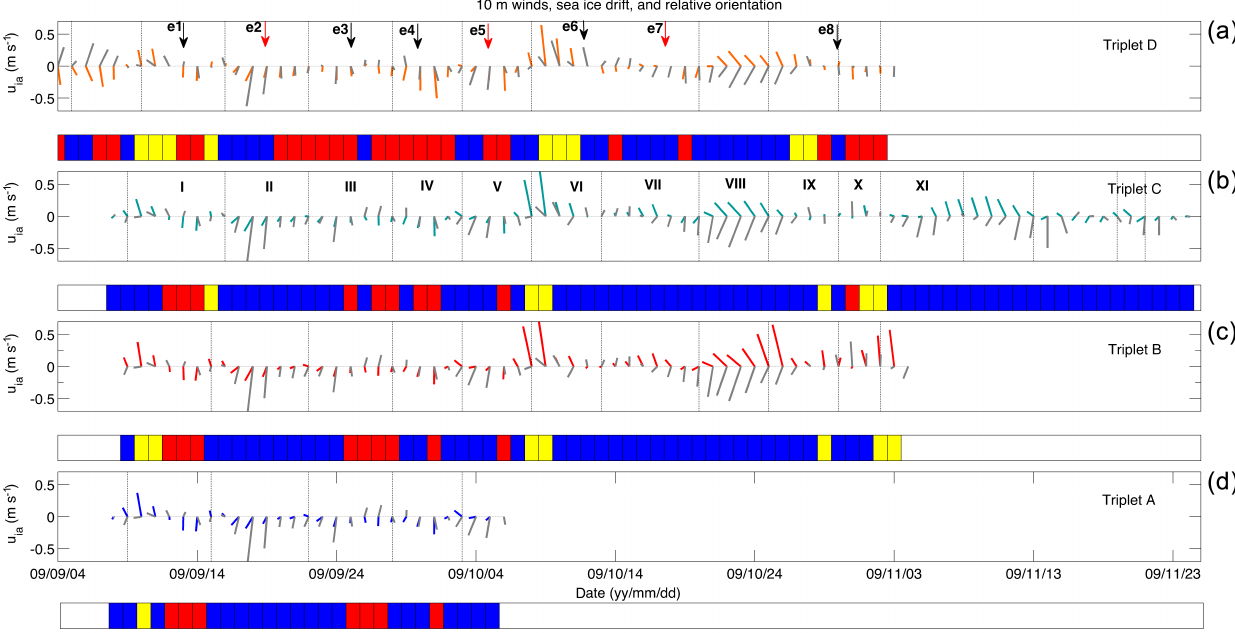
Figure 6. Winds, sea ice drift, and orientation relative to the coastline. Time series of 10m North American Regional Reanalysis (NARR) winds in the vicinity of the triplet centroids (grey vectors), sea ice drift for triplets A (d) to D (a) , and offshore (yellow), onshore (red), and alongshore (blue) ice drift orientation. Winds and ice drift show coherence in ice drift for triplets A to C and variations in triplet D. Orientation highlights increased free-drift conditions at higher latitudes associated with triplet D relative to lower latitude triplets. Directional changes e 1, e 3, e 4, e 6, and e 8 occur during reversals in wind and ice drift. Noteworthy also are directional changes in sea ice drift during persistent ( ∼ 3–4days) northerly winds (events e 2, e 5, and e 7). Of particular interest is strong offshore ice drift on 8 October due to easterly winds and strong Ekman convergence during a SLP high within a high ice concentration ( > 95%) ice regime. Red arrows associated with directional changes highlight events associated with persistent northerly surface